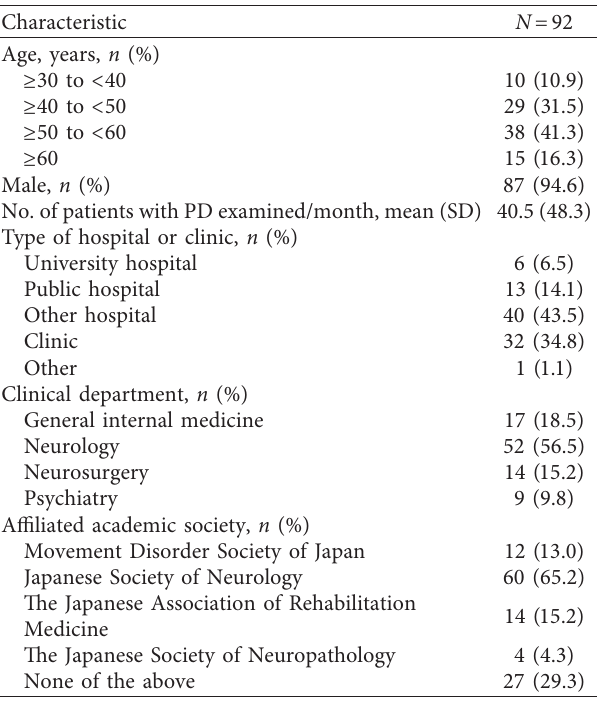
Table 2: Physician